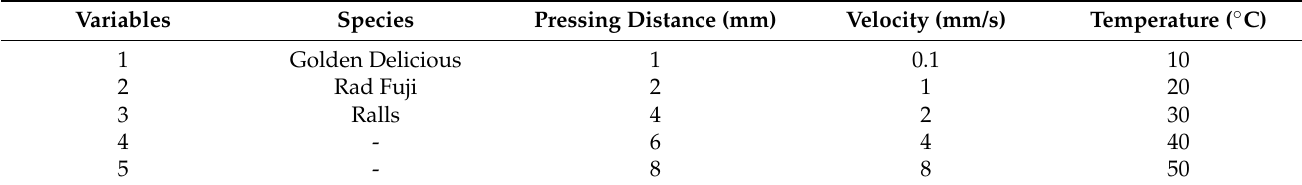
Table 1. Compression test